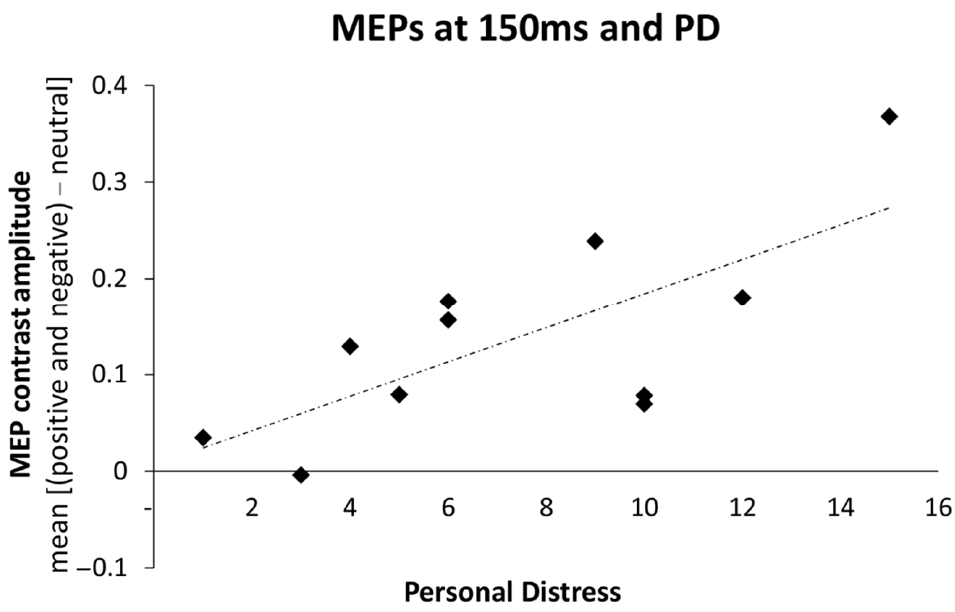
Figure 3. Simple correlation between MEP contrasts at 150 ms (amplitude during happy and fearful facial expressions minus neutral conditions) and the personal distress subscale of the Interpersonal Reactivity Index.